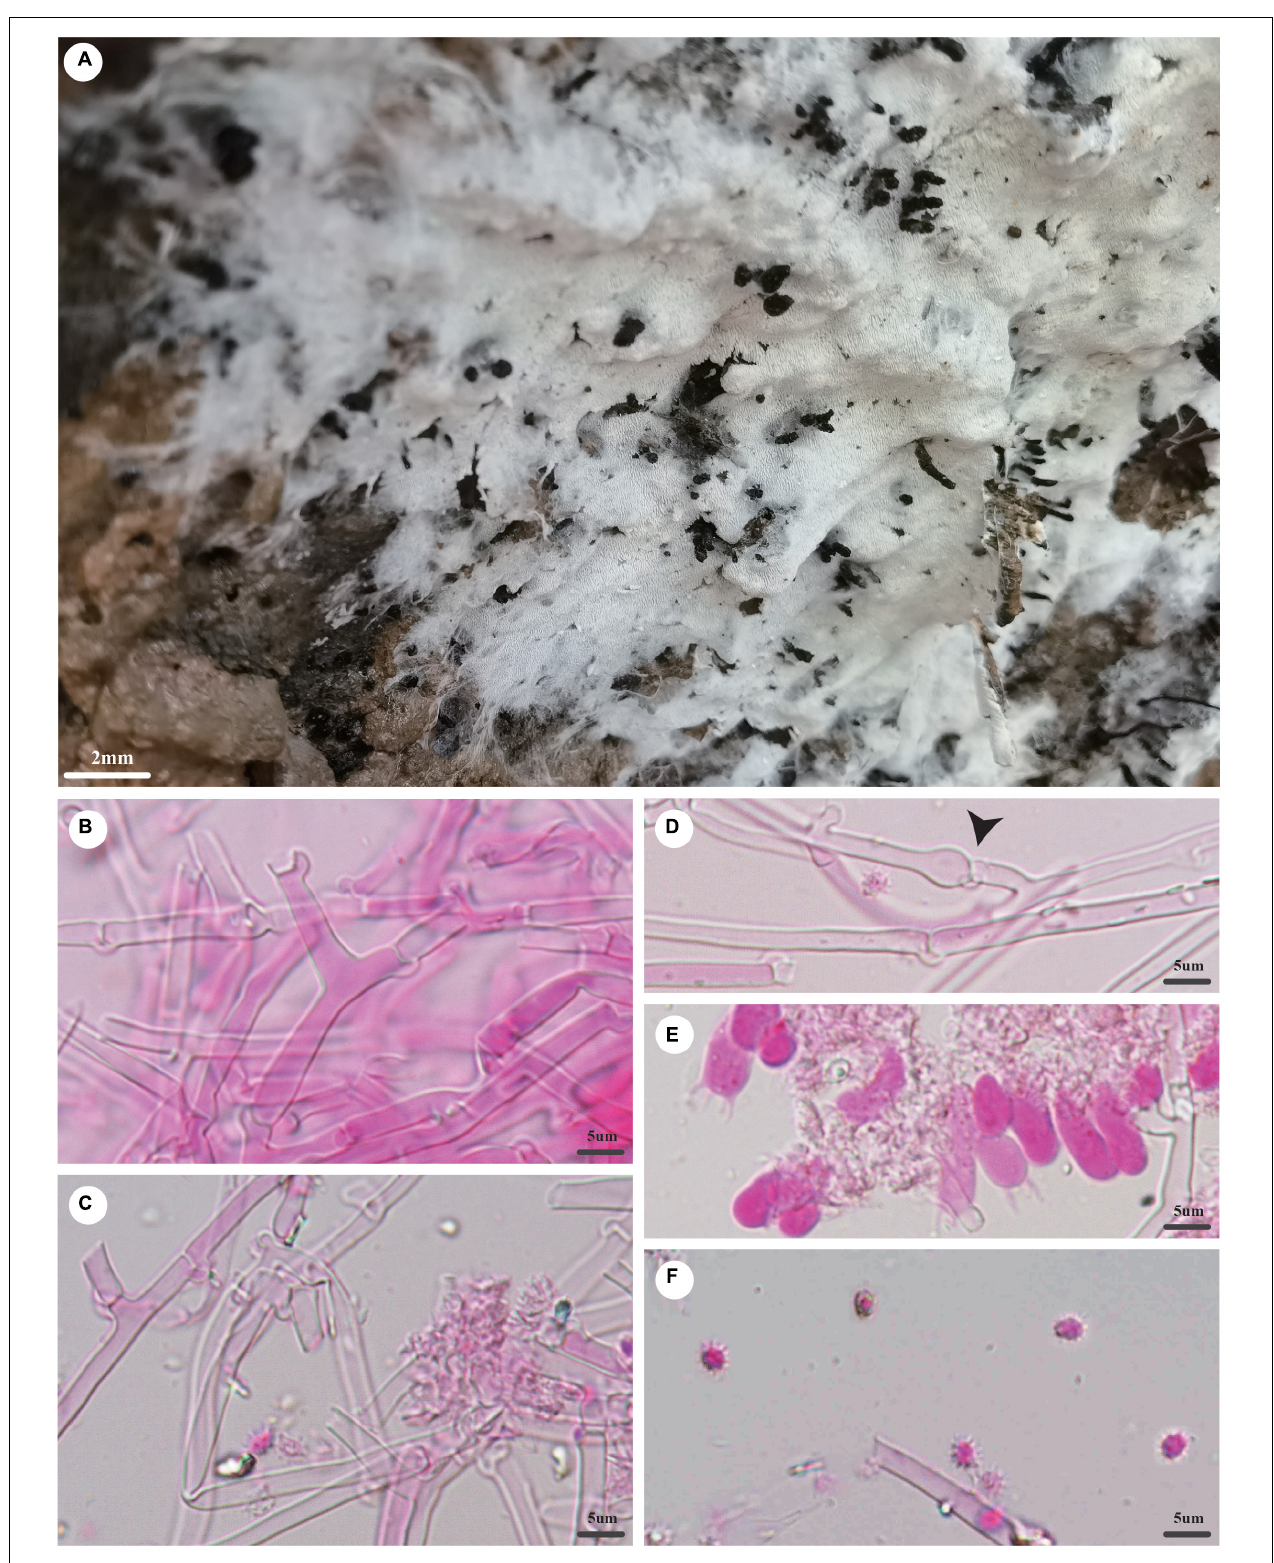
FIGURE 4 | Trechispora dentata (holotype, Dai 22565). (A) A basidioma, (B) hyphae from subiculum, (C) hyphae from trama, (D) hyphae with ampullate septa (black arrow), (E) basidia and basidioles, and (F) basidiospores. Photo by Ya-Ping Lian and Zhan-Bo Liu.